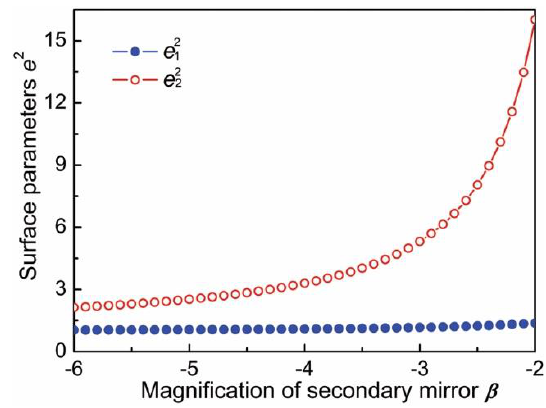
Figure 1. Curves of e 12 and e 22 versus β